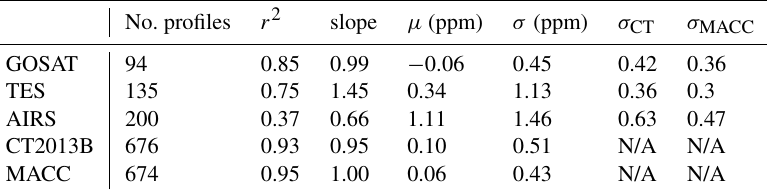
Table 1. Summary of all HIPPO comparisons. No. of profiles shows how many HIPPO profiles were used for the comparison. Correlation coefficients, fitted slope, mean difference µ , and standard deviation σ of the difference compared to HIPPO of all comparisons are computed using measurements normalized by the respective campaign average. For comparison, σ of model–HIPPO for the satellite co-locations and respective sensitivity are provided as